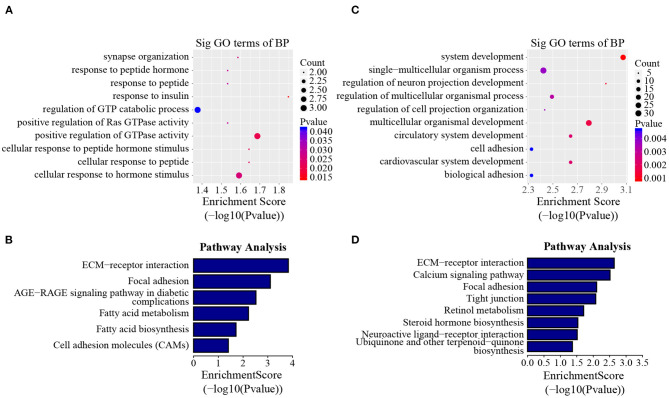
GO biological process and KEGG pathway analyses of line-dynamic m6A genes. (A) GO analysis of high m6A methylated genes (fat line vs. lean line; P < 0.05). (B) Pathway analysis of high m6A methylated genes (fat line vs. lean line; P < 0.05). (C) GO analysis of low m6A methylated genes (fat line vs. lean line; P < 0.05). (D) Pathway analysis of low m6A methylated genes (fat line vs. lean line; P < 0.05). BP, biological process; Sig, significant.